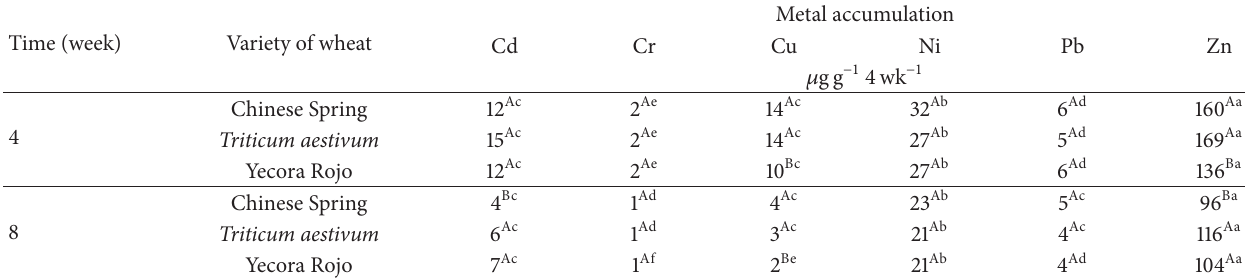
Table 4: Metal uptake rates (means where 𝑛 = 4 ) by shoots of three wheat cultivars grown on sand media amended with biosolids † . Time (week) Variety of